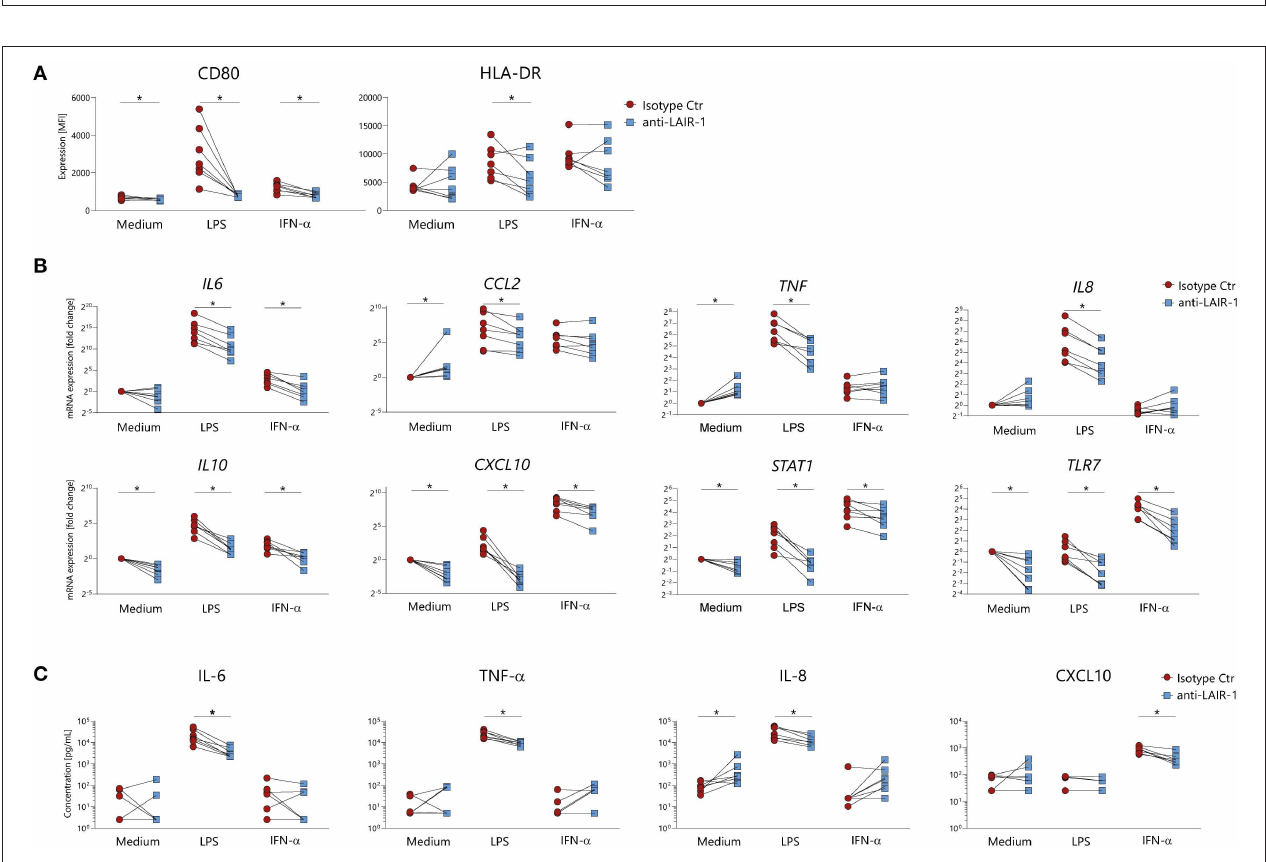
FIGURE 2 | Results are represented as mean with SD. Differences were considered statistically significant when p < 0.05 (Unpaired t -test) (C) LAIR-1 expression [represented as median fluorescence intensity (MFI)] on PBMCs stimulated overnight with different TLR agonists, cytokines and chemokines was assessed by flow